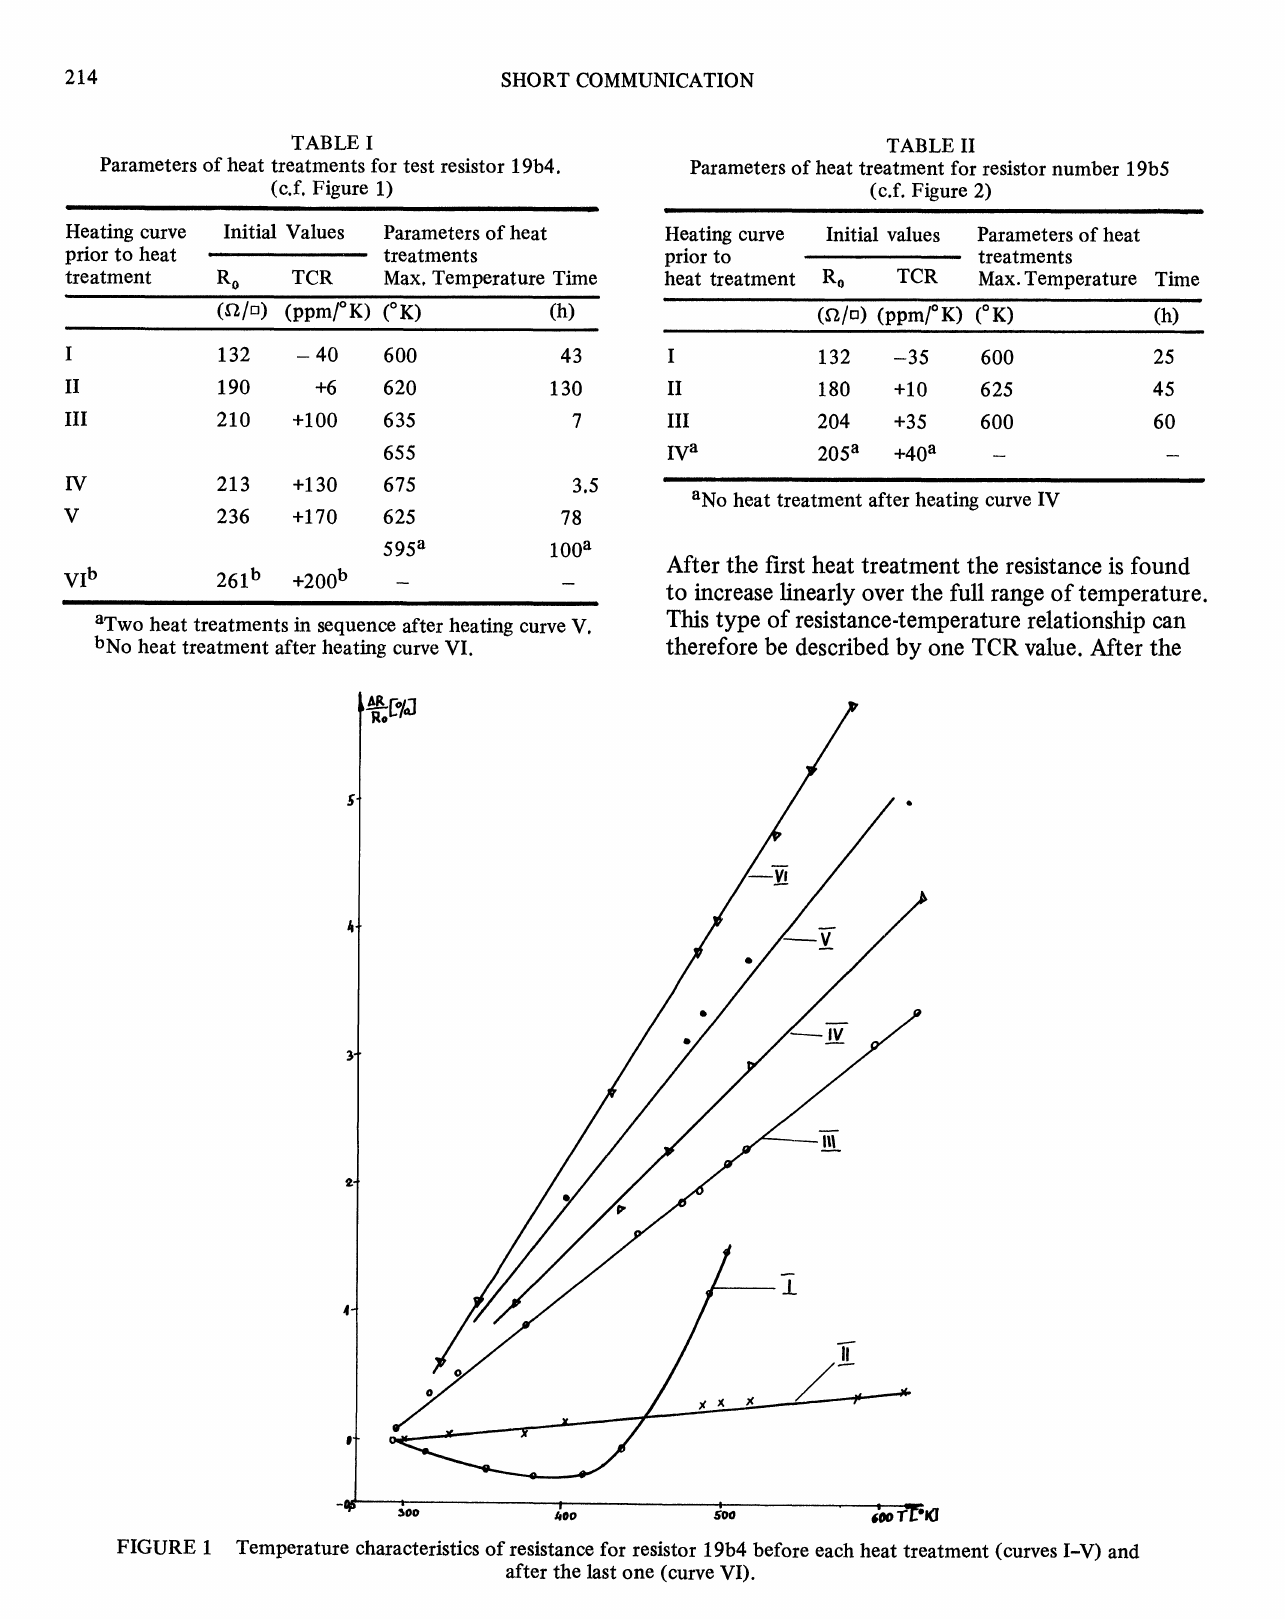
FIGURE Temperature characteristics of resistance for resistor 19b4 before each heat treatment (curves I-V) and after the last one (curve